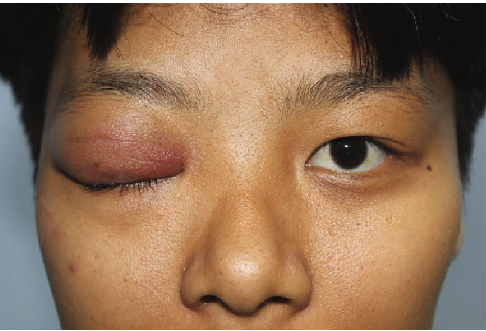
Figure 1: This fi gure shows the right upper eyelid swelling and ptosis with a palpable fi rm mass 20mm in diameter.